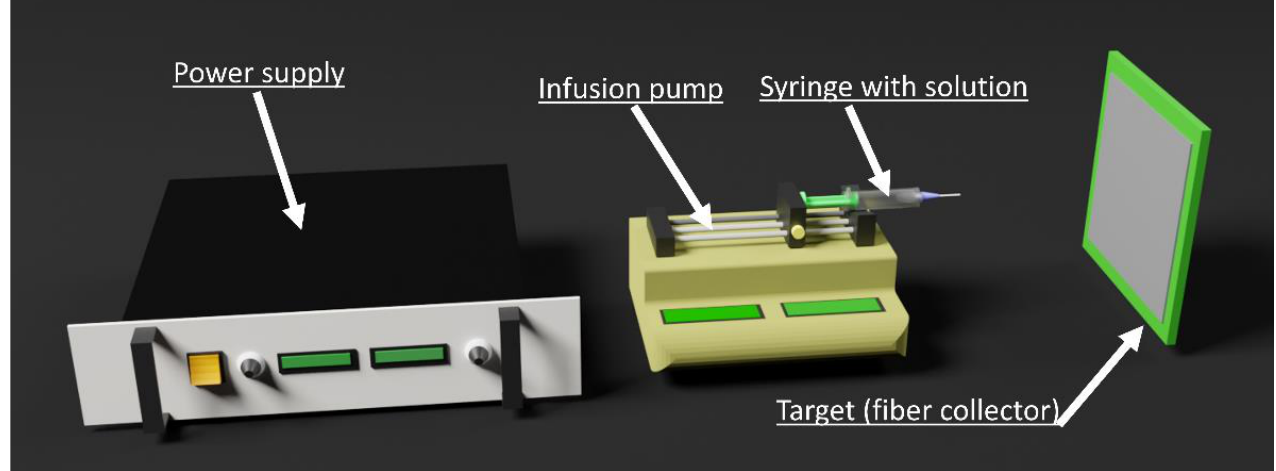
Figure 8. Schematic of a typical electrospinning setup.